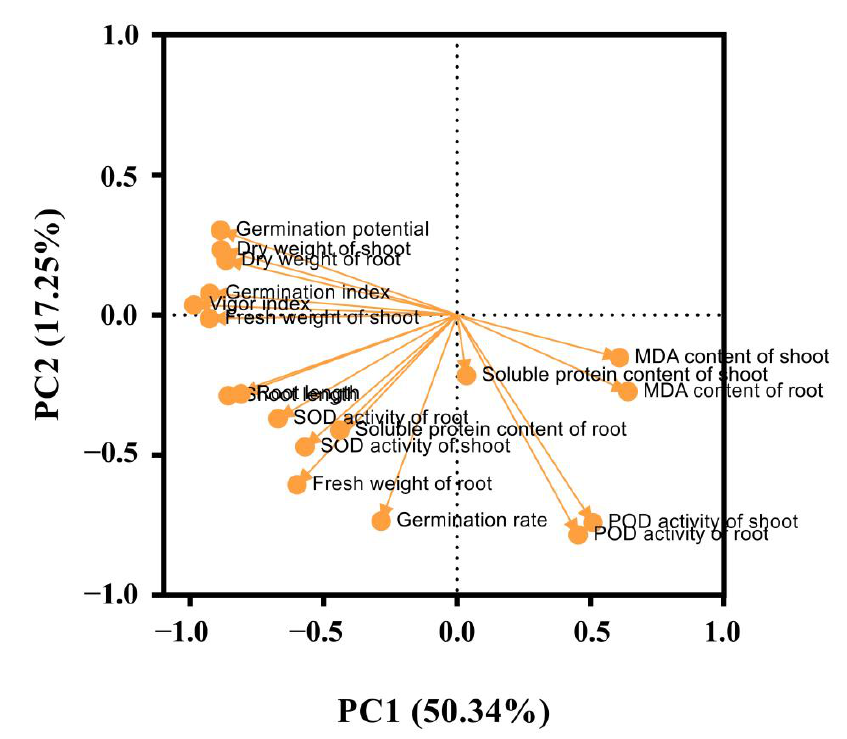
Figure 8. Principal component analysis of melatonin and flooding stress.